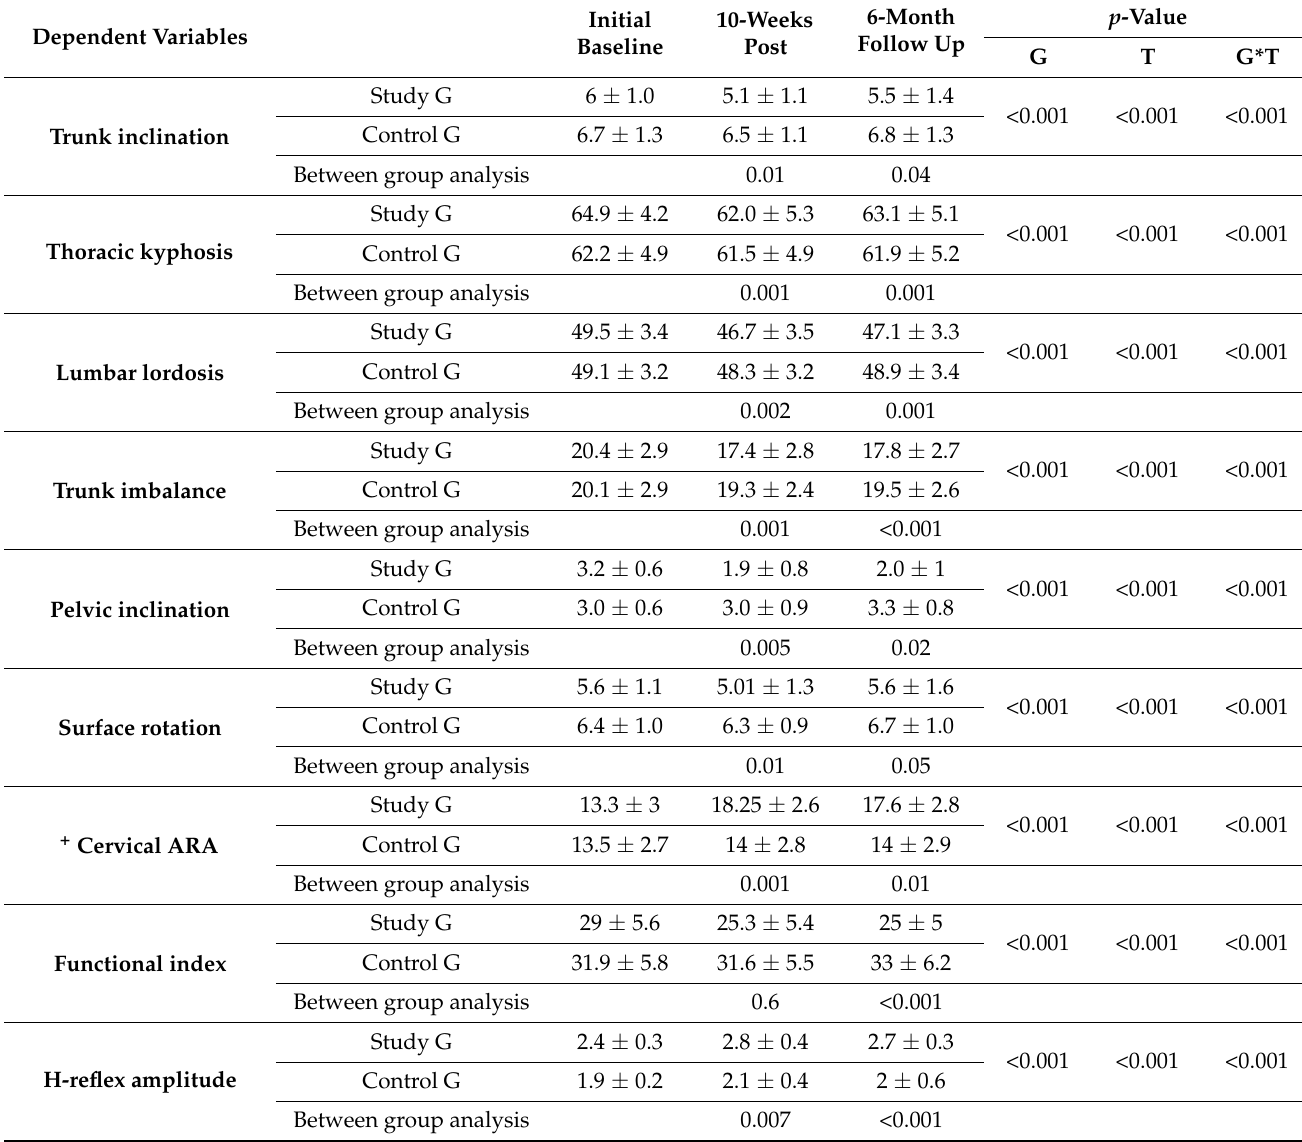
Table 2. Means, standard deviations ( ± SD), and statistical significance for all outcome variables in the control group versus the study subjects at initial, 10 weeks of treatment, and 6-month follow